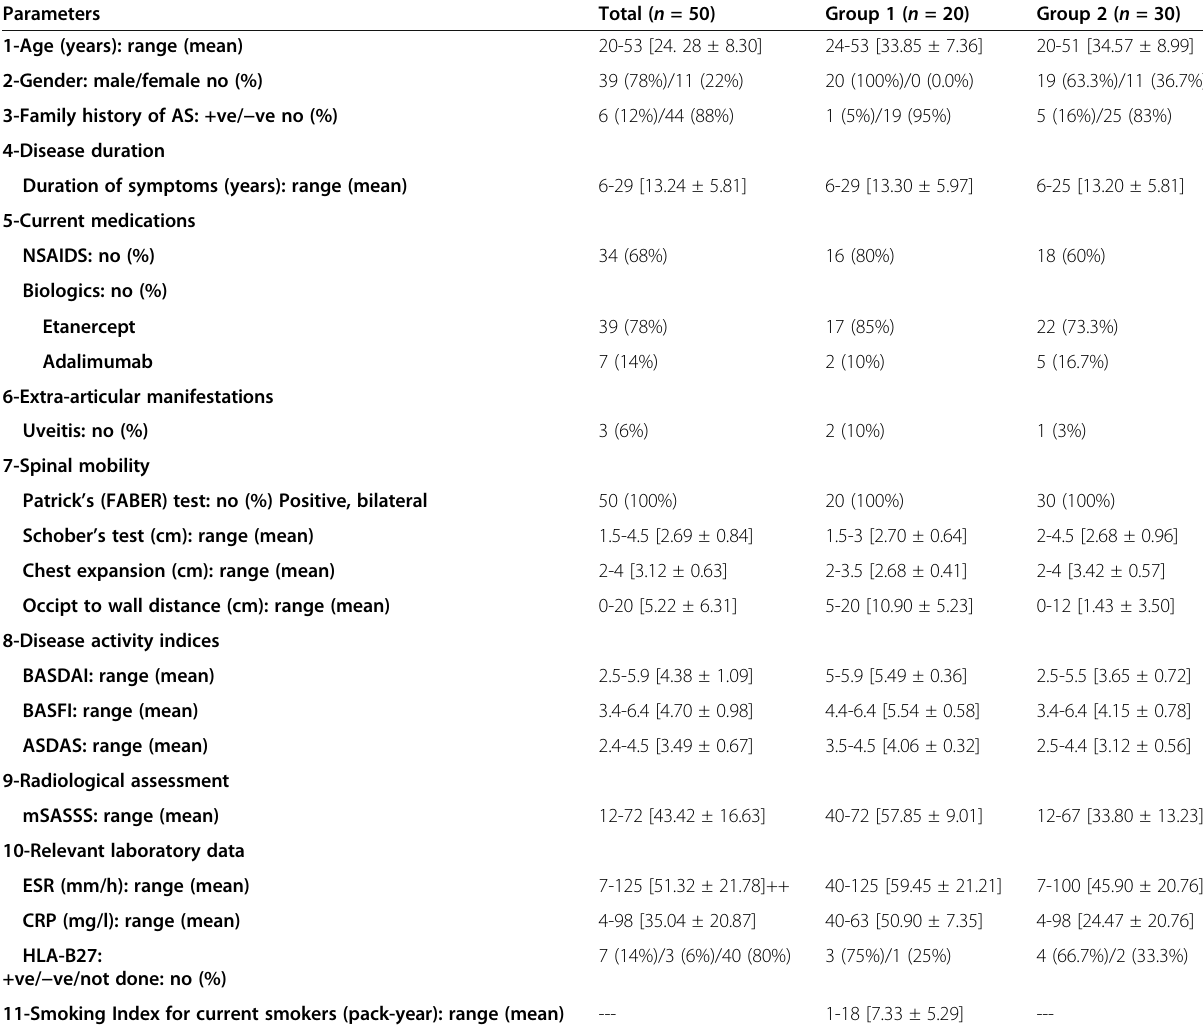
Table 1 Demographic, clinical, laboratory, and radiographic data of the patients with ankylosing spondylitis (AS) included in the study ( n = 50)